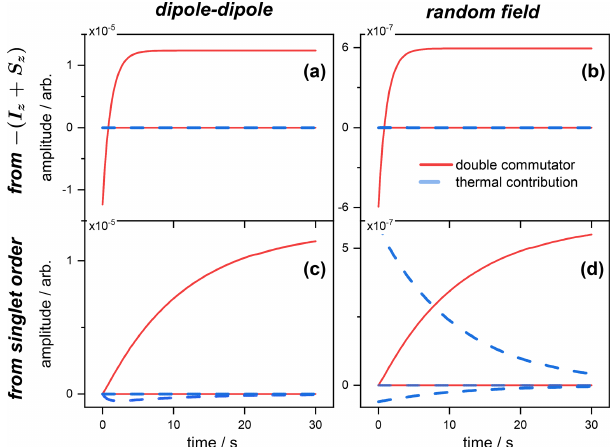
Figure 1. Expected values of the magnetization spin operator O = I z + S z , with the contributions of the double commutator (red curves) and thermal (blue curves) parts of the Redfield relaxation operator to the magnetization from the different operators S q p (see Table C1). Panels (a) and (b) correspond, respectively, to the dipolar and random field relaxation of the spins inverted from a Boltzmann equilibrium. Panels (c) and (d) correspond, respectively, to the dipo- lar and random field relaxation of the spins initially prepared in a singlet state. Simulations were performed using the Scilab software (https://scilab.org, last access: 31 January